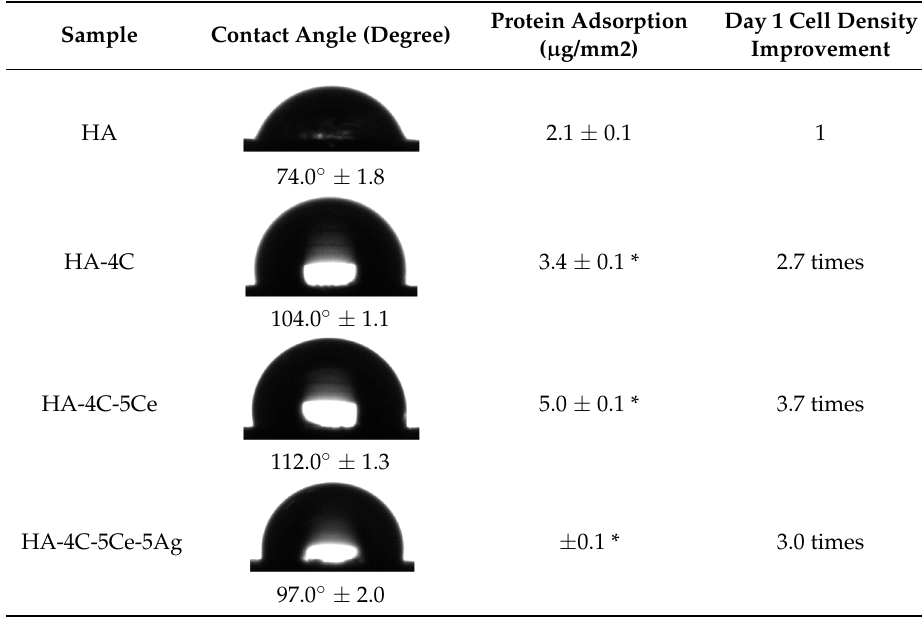
Table 3. Water contact angles (WCA), the corresponding BSA adsorption, and cell density improvement on the HA-based coatings (* indicates p values of mean adsorbed proteins on composites when compared to HA control: <0.0001).